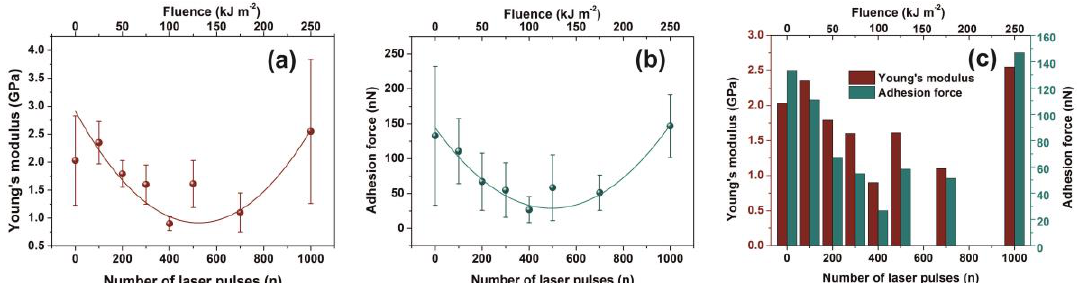
Figure 7. Young’s modulus and adhesion force of irradiated polyacrylamide (PAM) surfaces showing enhanced carbonization at higher laser fluence. ( a ) Young’s modulus; ( b ) adhesion force of a PAM surface irradiated at different laser fluence up to 250 J m − 2 ; ( c ) Young’s modulus and adhesion force column charts of PAM vs. laser fluence.